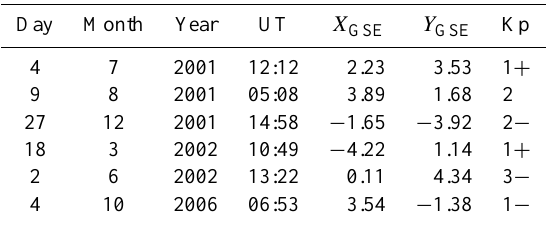
Table 1. Cluster equatorial crossings of the outer plasmasphere analysed, during quiet or moderately active magnetospheric con- ditions, for which the RPA mode was in operation. The distribution of these events in the X GSE - Y GSE plane is shown in Fig.